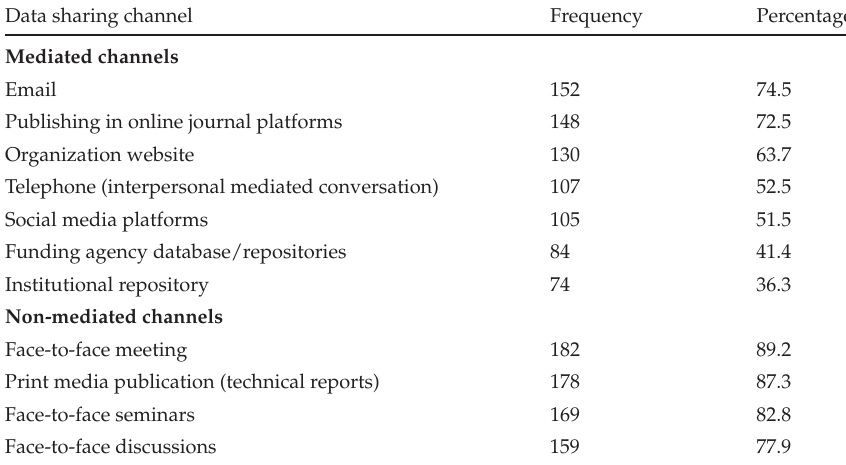
Table 1: Channels existing and used in agriculture research institutions (n =